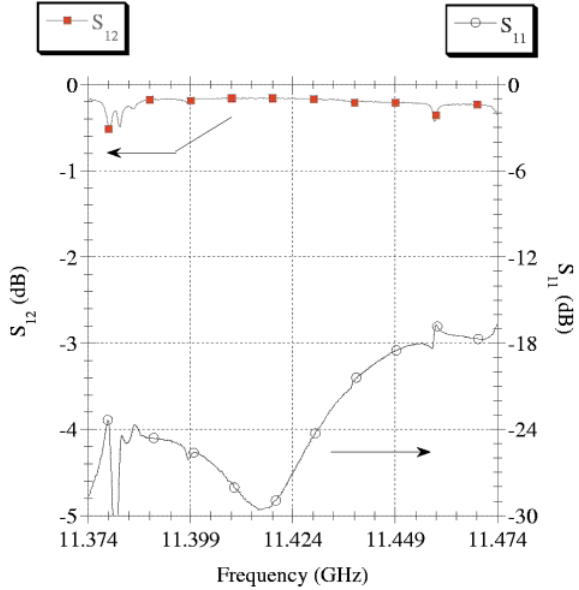
FIG. 10. (Color) Measured frequency response of two TE 12 mode transducers connected